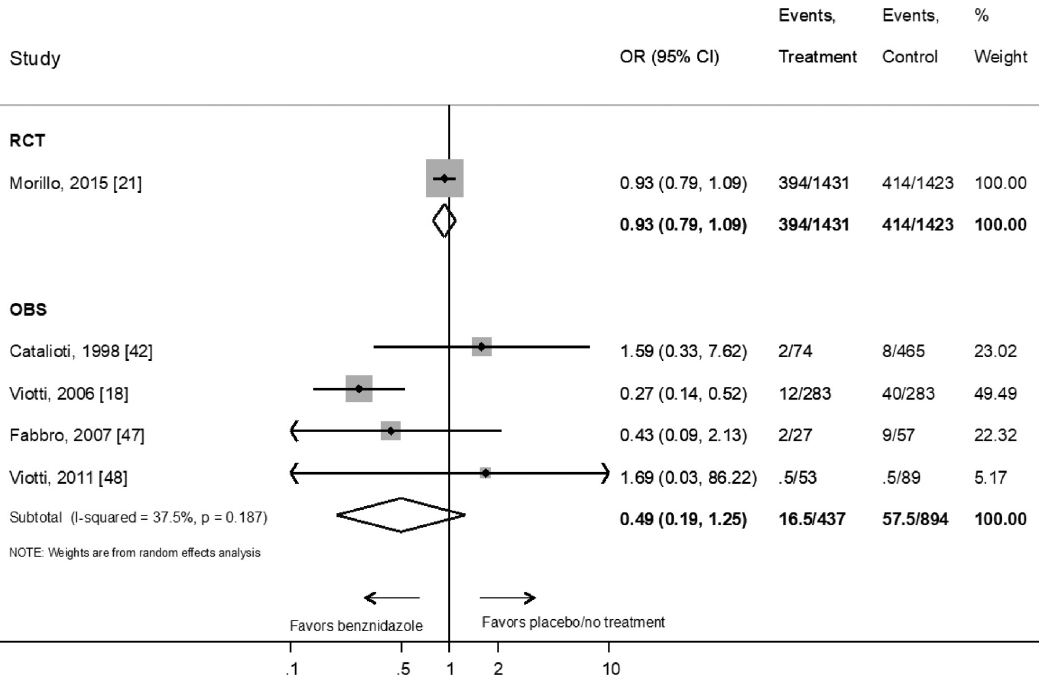
Fig 4. Evaluation of the effect of benznidazole compared with placebo or no treatment on the response to therapy in adults according to clinical primary endpoint by type of study. RCT: Randomized Clinical Trial; OBS: prospective observational